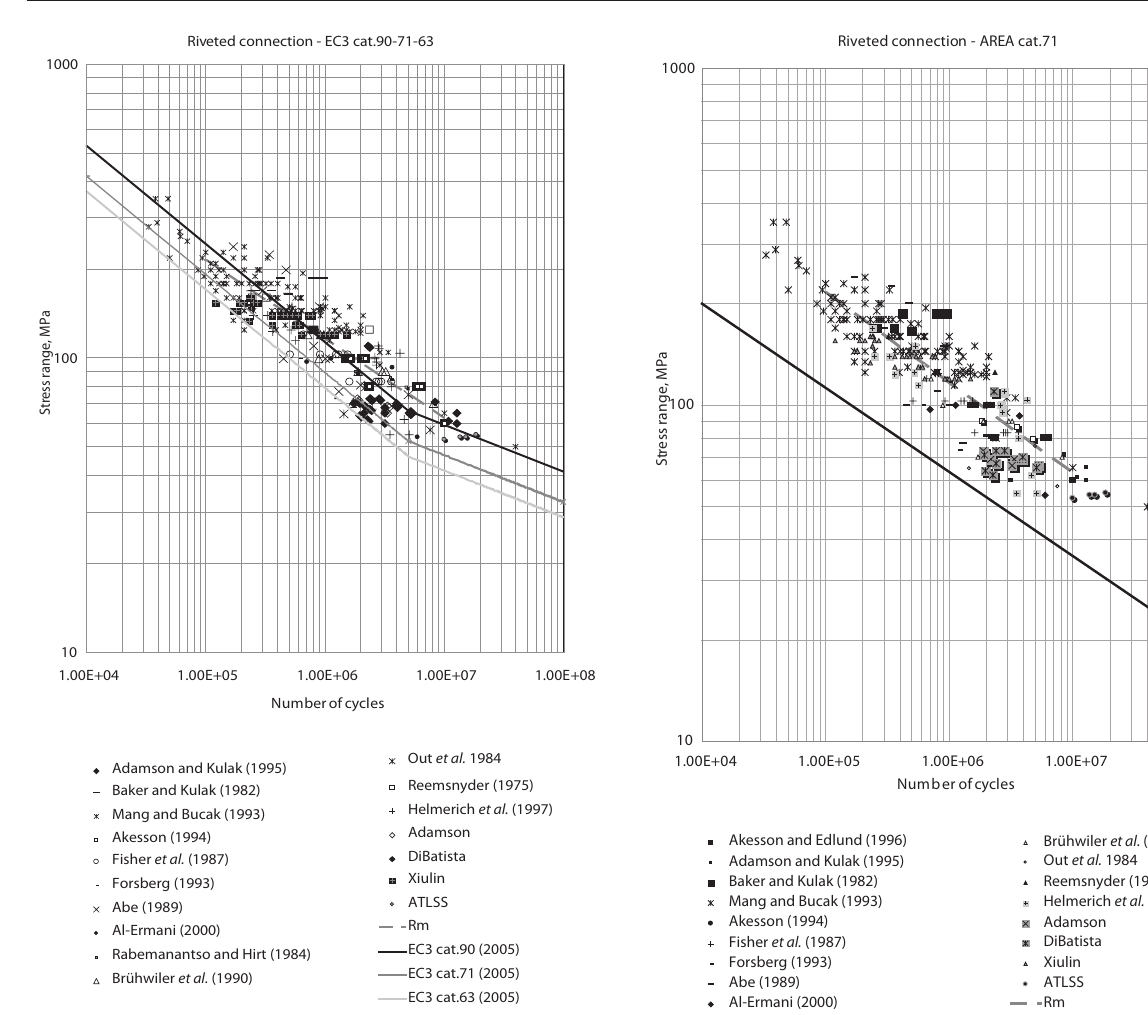
Fig. 6 . Test data, best fit and fatigue design curve, category D , according AREMA:2003 (Pipinato 2008)